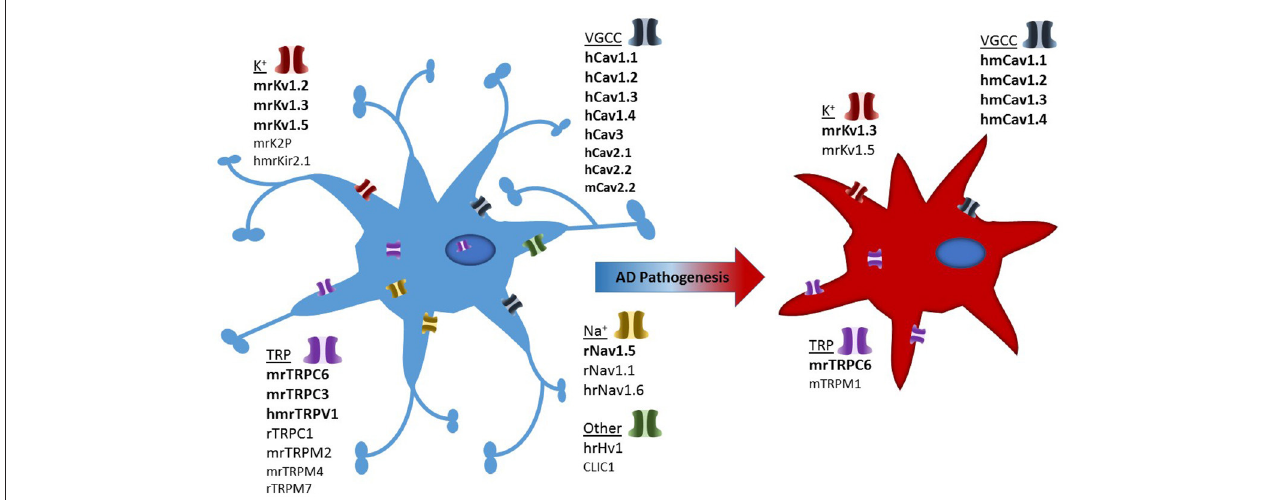
FIGURE 2 | Illustration depicting presence of ion channels observed in microglial models and which of these have confirmed activity in Alzheimer’s disease associated microglia. Strength of evidence is depicted in bold to un-bold text. In addition each channel is pre-fixed with the species in which they have been investigated: h, human; m, mouse; r,